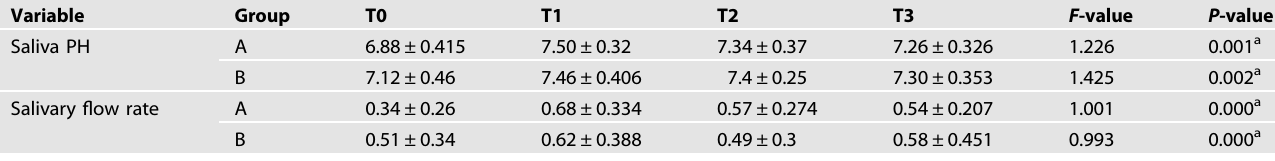
Table 3. Findings of the two way repeated measures ANOVA test to analyze the difference between the time points in each group regarding the two variables.